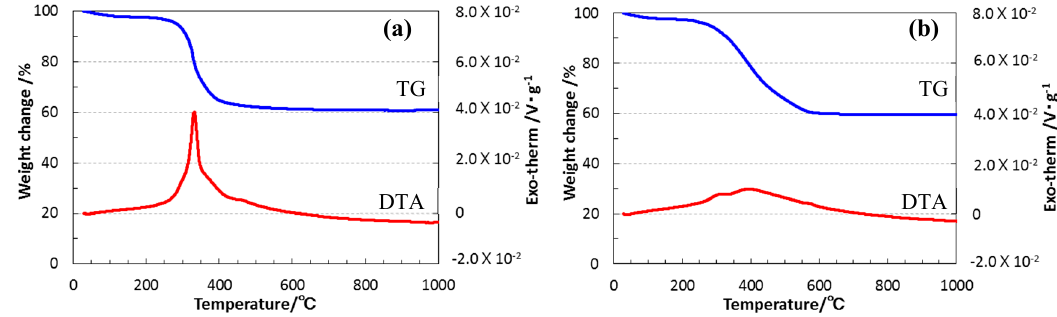
Figure 3. Thermogravimetric/differential thermal analysis (TG-DTA) curves for EtOSZ measured ( a ) in air and ( b ) in N 2 .